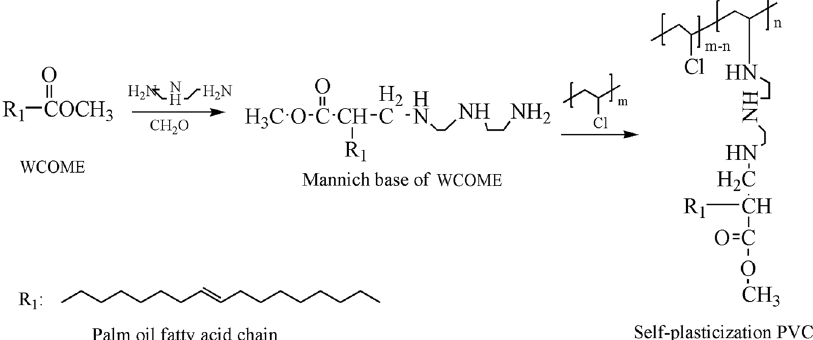
Figure 1. Preparation of self-plasticization